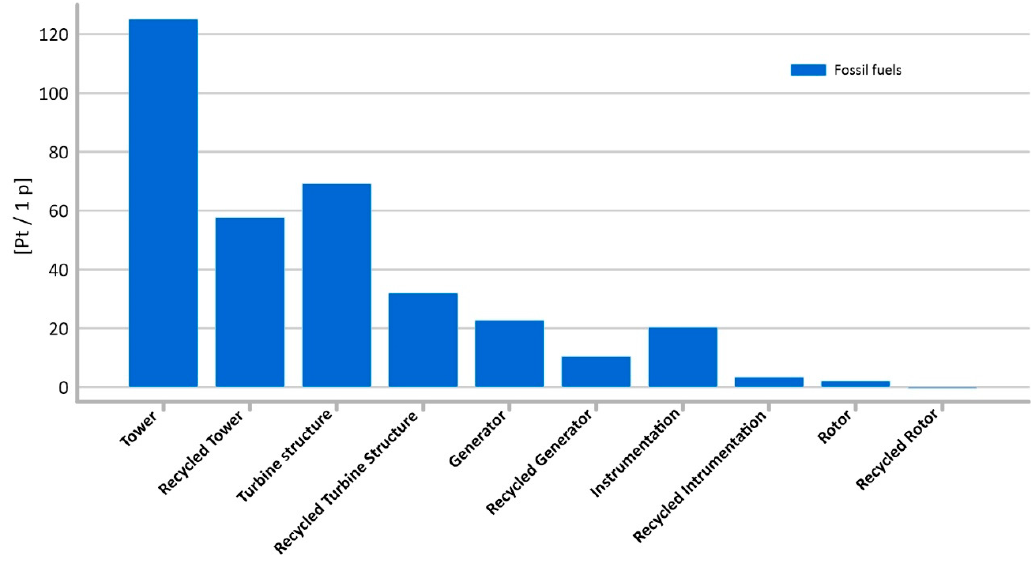
Figure 16. Results of grouping and weighting—fossil fuels.